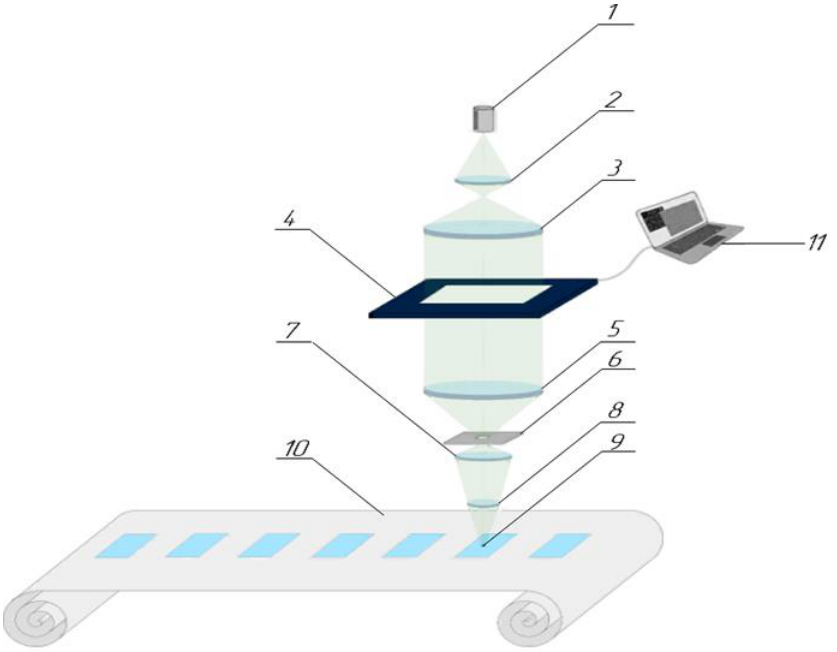
Figure 10. Photopolymer security holograms individualization: ( 1 ) is a LED or laser source; ( 2 ) is a condenser lens; ( 3 ) is a collimation lens of the lighting system; ( 4 ) is a spatial light modulator based on liquid crystals, where CGH is displayed; ( 5 ) is a Fourier lens; ( 6 ) is a spatial filter (diaphragm); ( 7 ) is a lens; ( 8 ) is a micro-lens; ( 9 ) is a personalized i -th micro-CGH; ( 10 ) is a photopolymer material; ( 11 ) is a personal computer for CGH